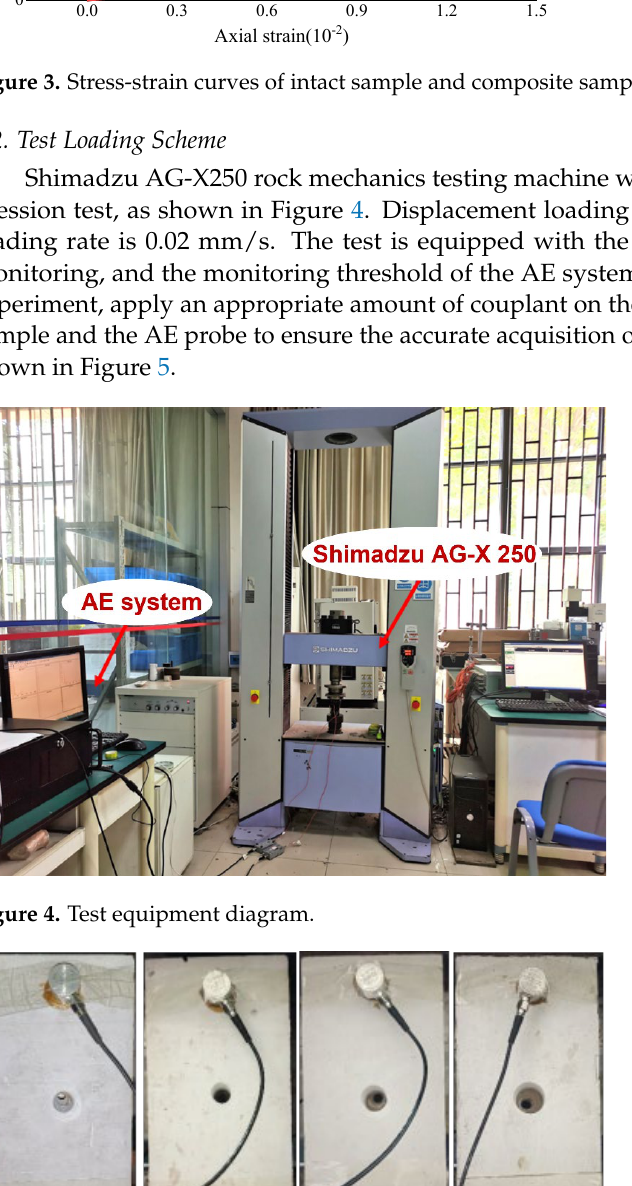
(1) Figure 6. Sample stress–strain curve. (2) Energy dissipation index. According to the research needs, the energy dissipation index is redefined in this pa- per. Where 𝐾𝐾 𝐸𝐸 is the ratio of the difference between the pre − peak strain energy ( 𝑈𝑈 𝑎𝑎 ) of the small borehole sample and the pre − peak strain energy ( 𝑈𝑈 𝑏𝑏 ) of other borehole samples to the pre − peak strain energy of the small borehole sample, which is given by: 𝑲𝑲 𝑬𝑬 = 𝑼𝑼 𝒂𝒂 − 𝑼𝑼 𝒃𝒃 𝑼𝑼 𝒂𝒂 (2) Where: 𝐾𝐾 𝐸𝐸 represents the amount of energy dissipation during the loading process of the sample. In the case of excluding other energy losses, the larger the 𝐾𝐾 𝐸𝐸 , the better the pres- sure relief effect of the sample.